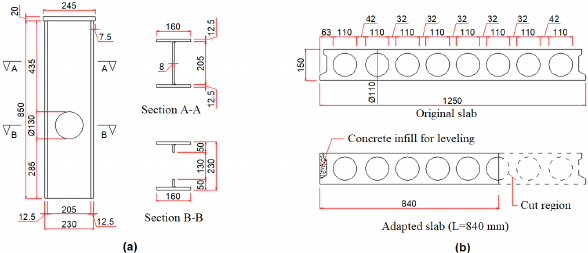
Fig. 5: Geometry of components – (a) Steel beam with web circular opening; (a) hollow core slab